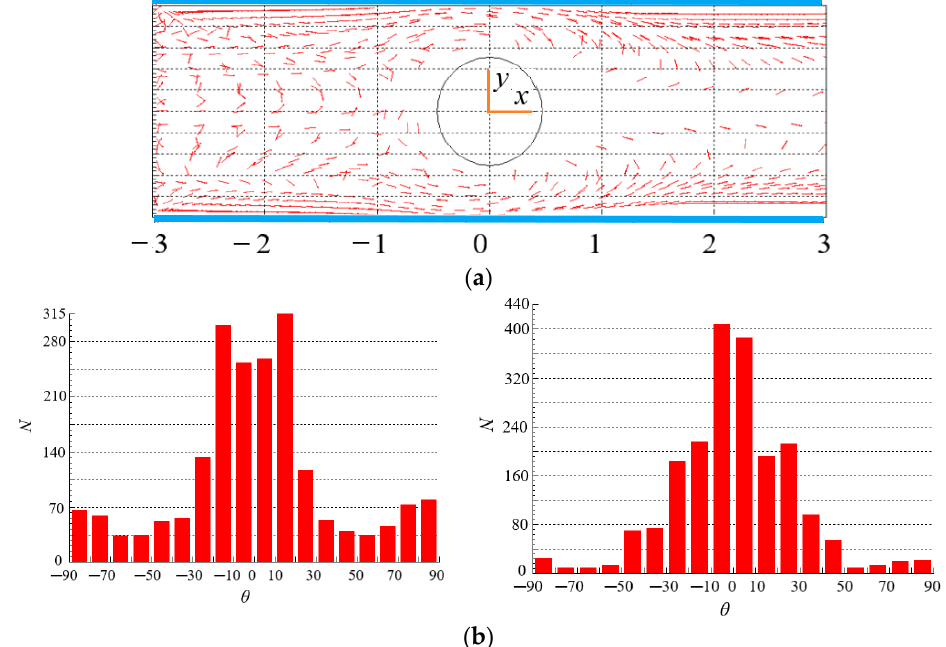
Figure 12. Spatial and orientation distributions of particles at β = 8 (Re = 2, n = 1.3). ( a ) spatial distribution. ( b ) orientation distribution: left: contraction flow ( x < 0); right: expansion flow ( x > 0).